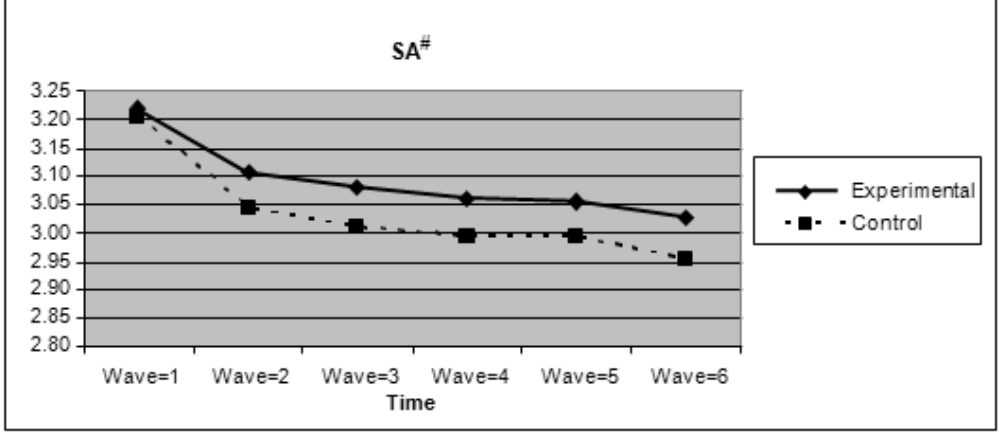
FIGURE 4. Growth trajectories of the experimental participants and control participants using SA # as an outcome indicator. # School adjustment